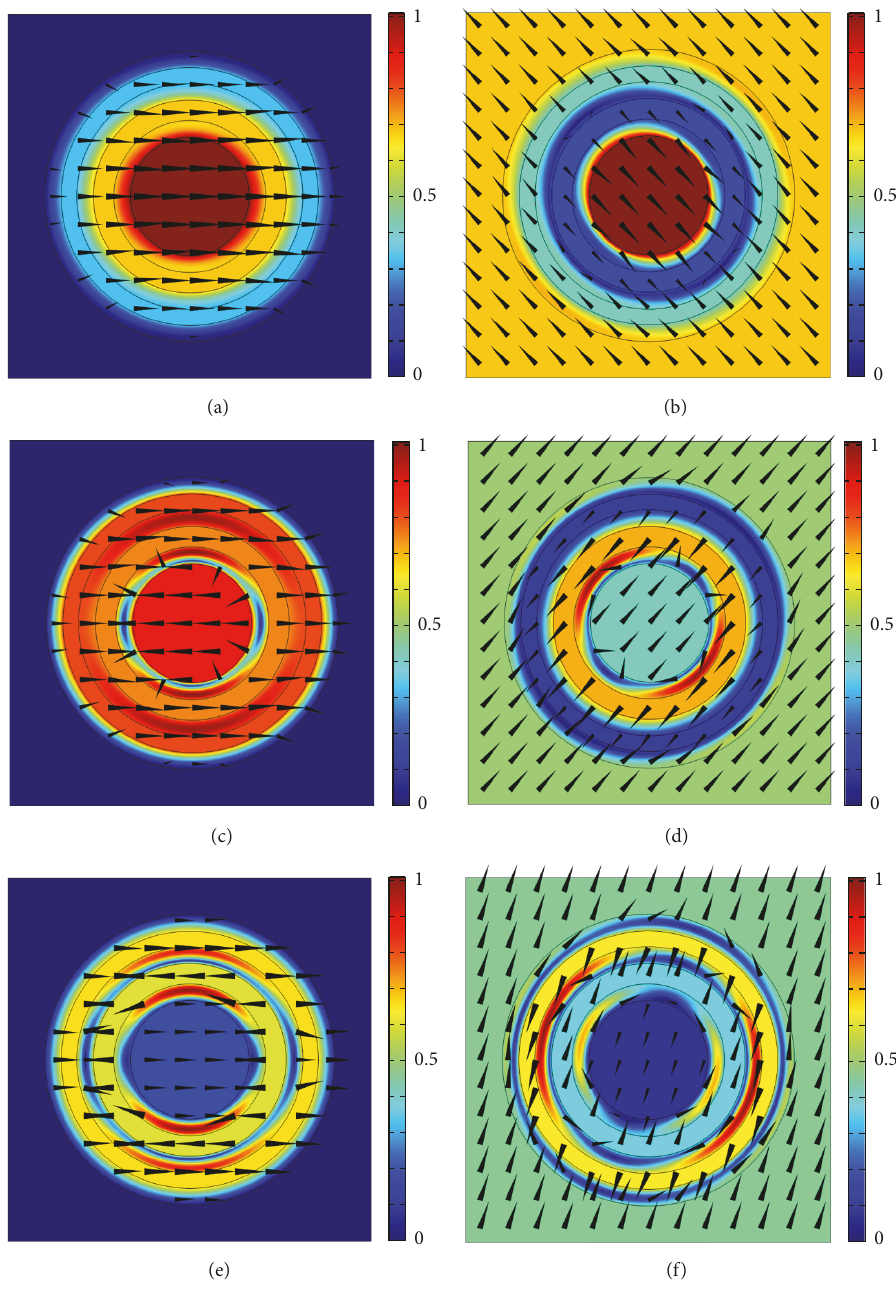
Figure 7: Vibration modes at lower edge (a) and upper edge (b) of the first band gap, at lower edge (c) and upper edge (d) of the second band gap, and at lower edge (e) and upper edge (f) of the third band gap in the triple-oscillator acoustic metamaterial system. The color bar represents the normalized